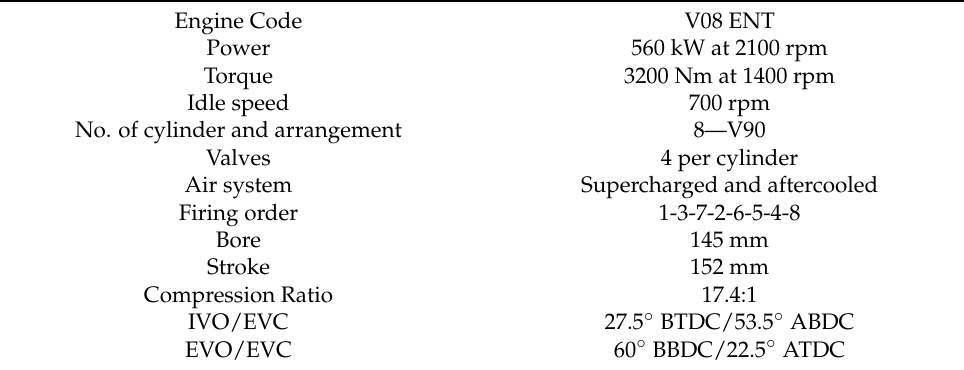
Table 3. Engine characteristics